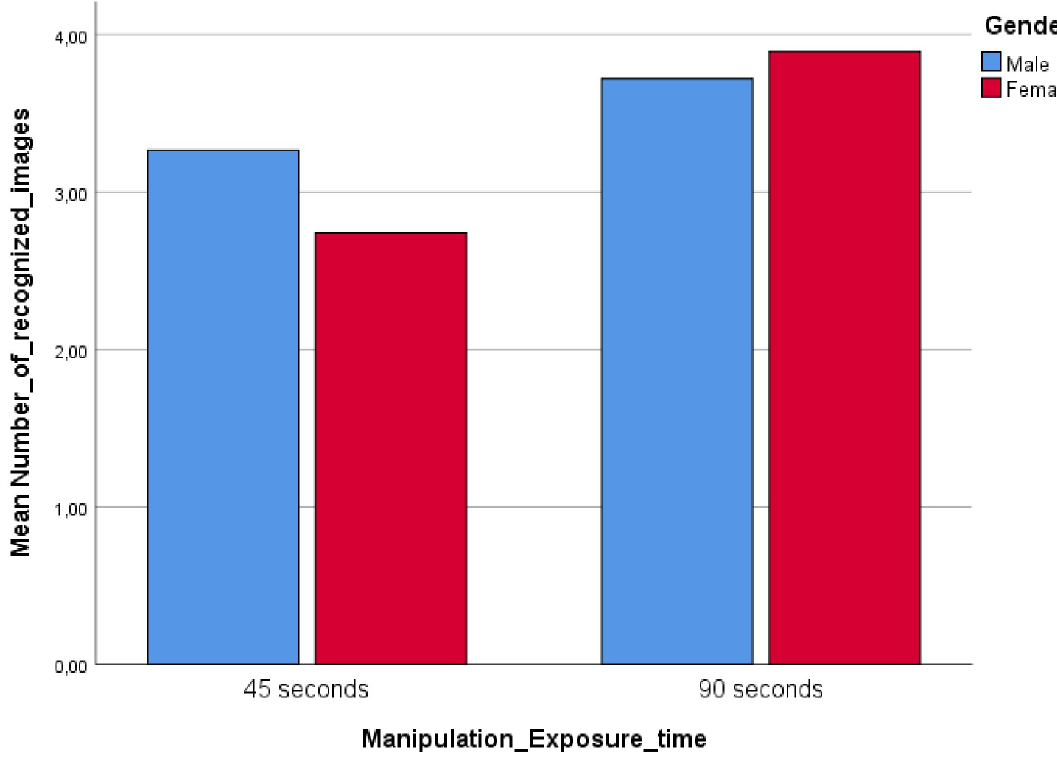
Fig 4. Study 3: Interaction between exposure time and gender.